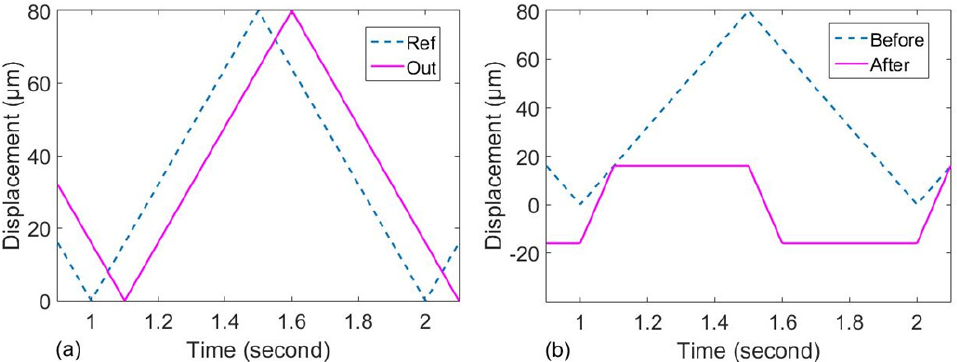
Figure 7. Comparison results. ( a ) Reference and open-loop input. ( b ) Tracking error before and after adding compensation in the initial state of the ILC.